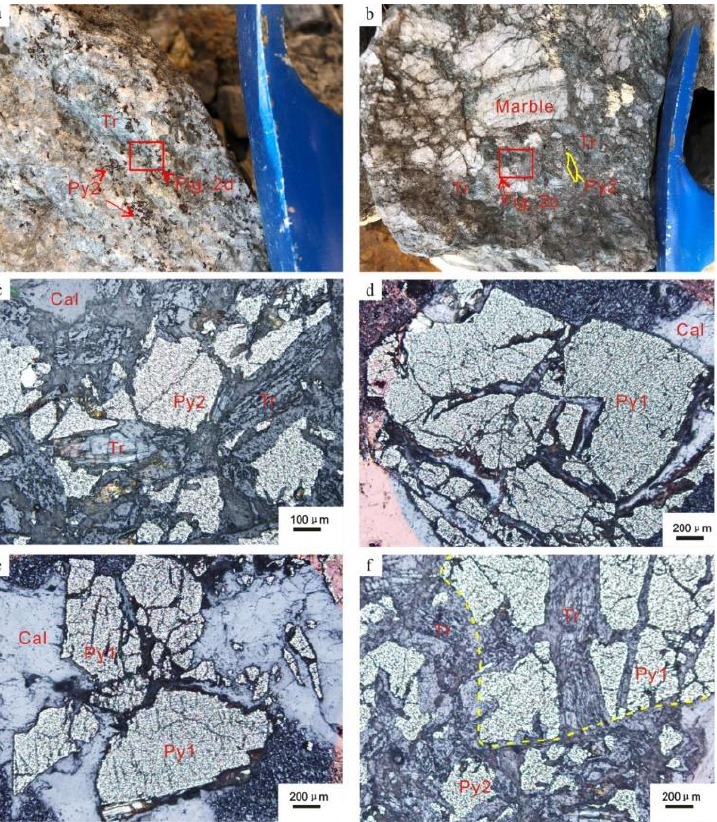
Figure 2. Representative outcrops and photomicrograph of ores from the Lijiapuzi gold deposit. ( a , b ) Field photos of Au-bearing pyrites and radial tremolite in country rock marbles. ( c ) Pho- tomicrograph of ore-bearing pyrite and tremolite under a transmission ray. ( d – f ) Reflected light photomicrograph of different stages of ore-bearing pyrite. Cal—calcite; Py1—early-stage pyrite; Py2—late-stage pyrite; Tr — tremolite.